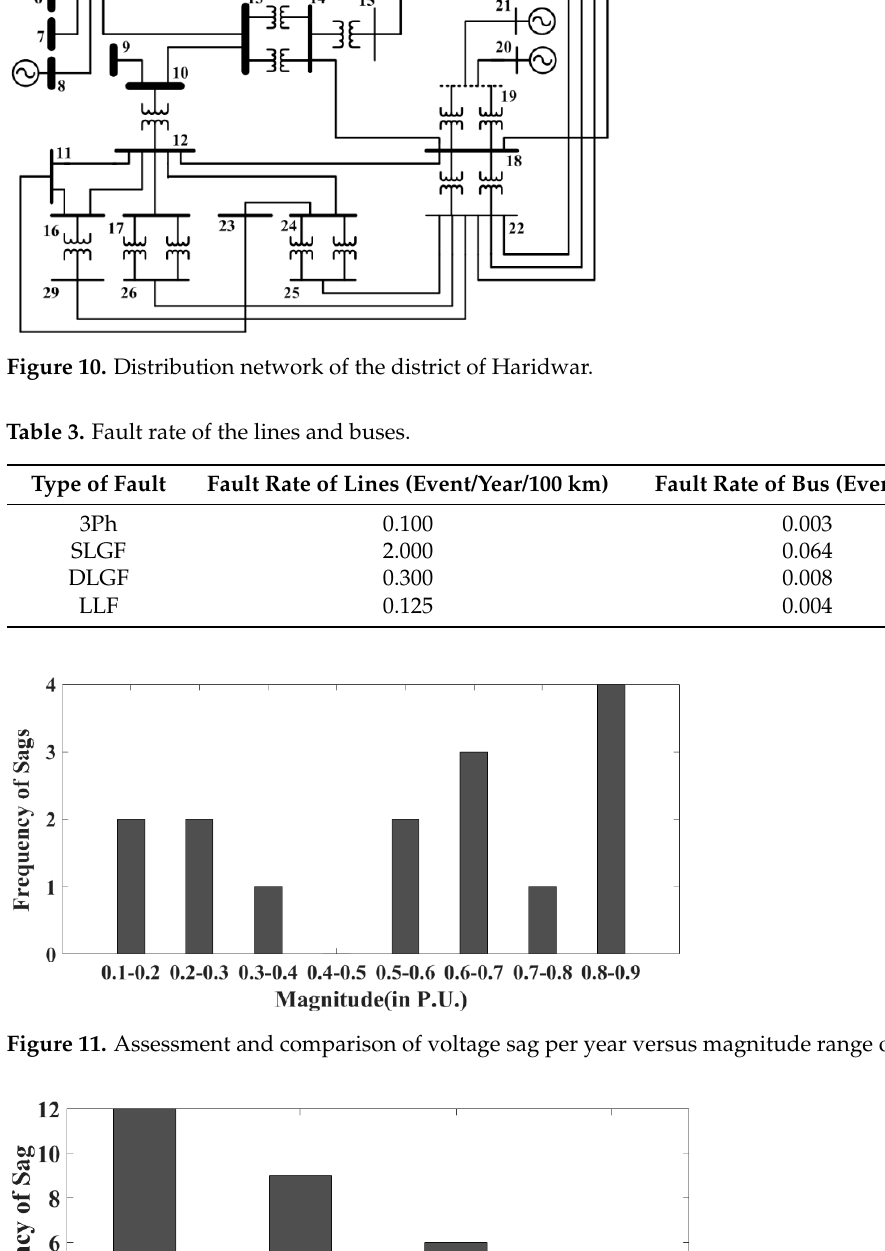
Figure 12. Frequency of sags versus duration on bus 10.